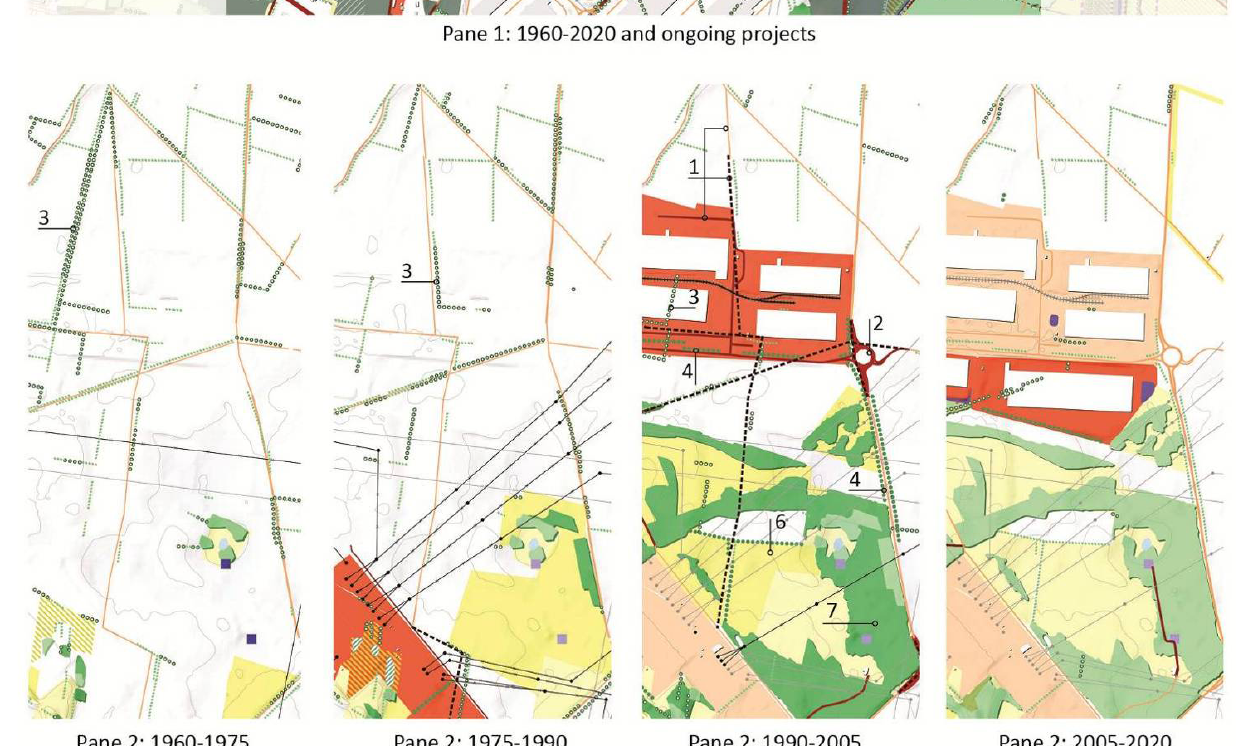
Figure 7. Extract 2 from the palimpsest mapping: The industrial estate forest park. Source: Author.